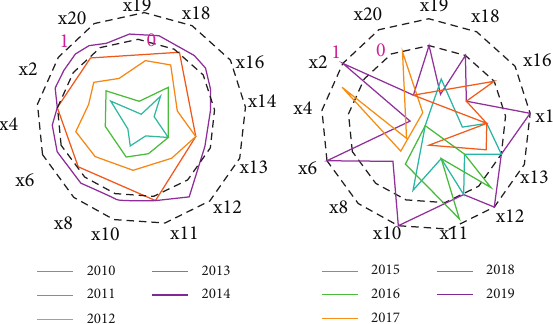
Figure 7: Environmental protection treatment and harmless